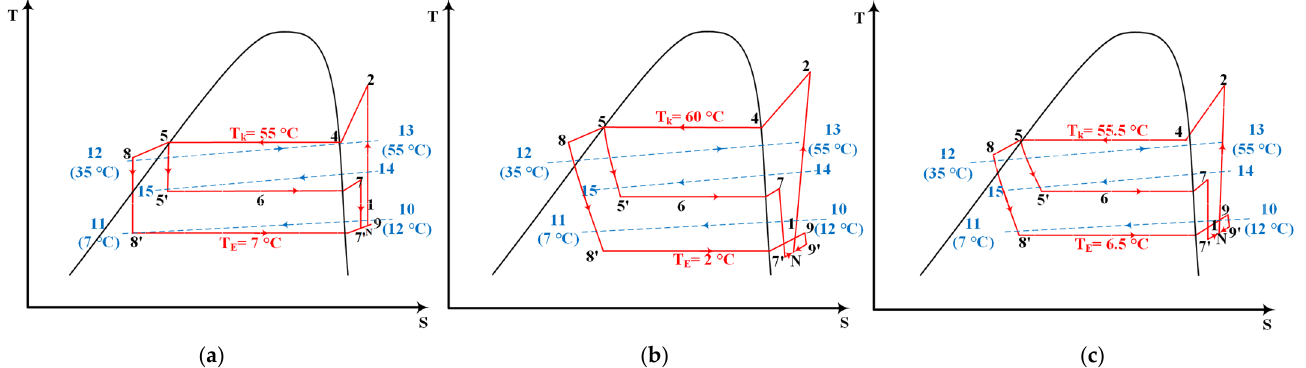
Figure 3. T-s diagram of the investigated system under different conditions: ( a ) ideal, ( b ) real, and ( c ) unavoidable.